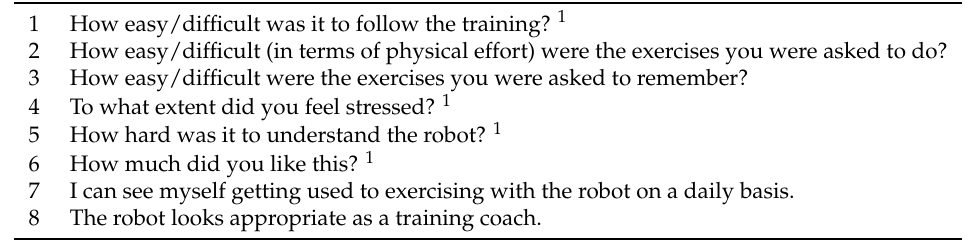
Table 3. The used task evaluation